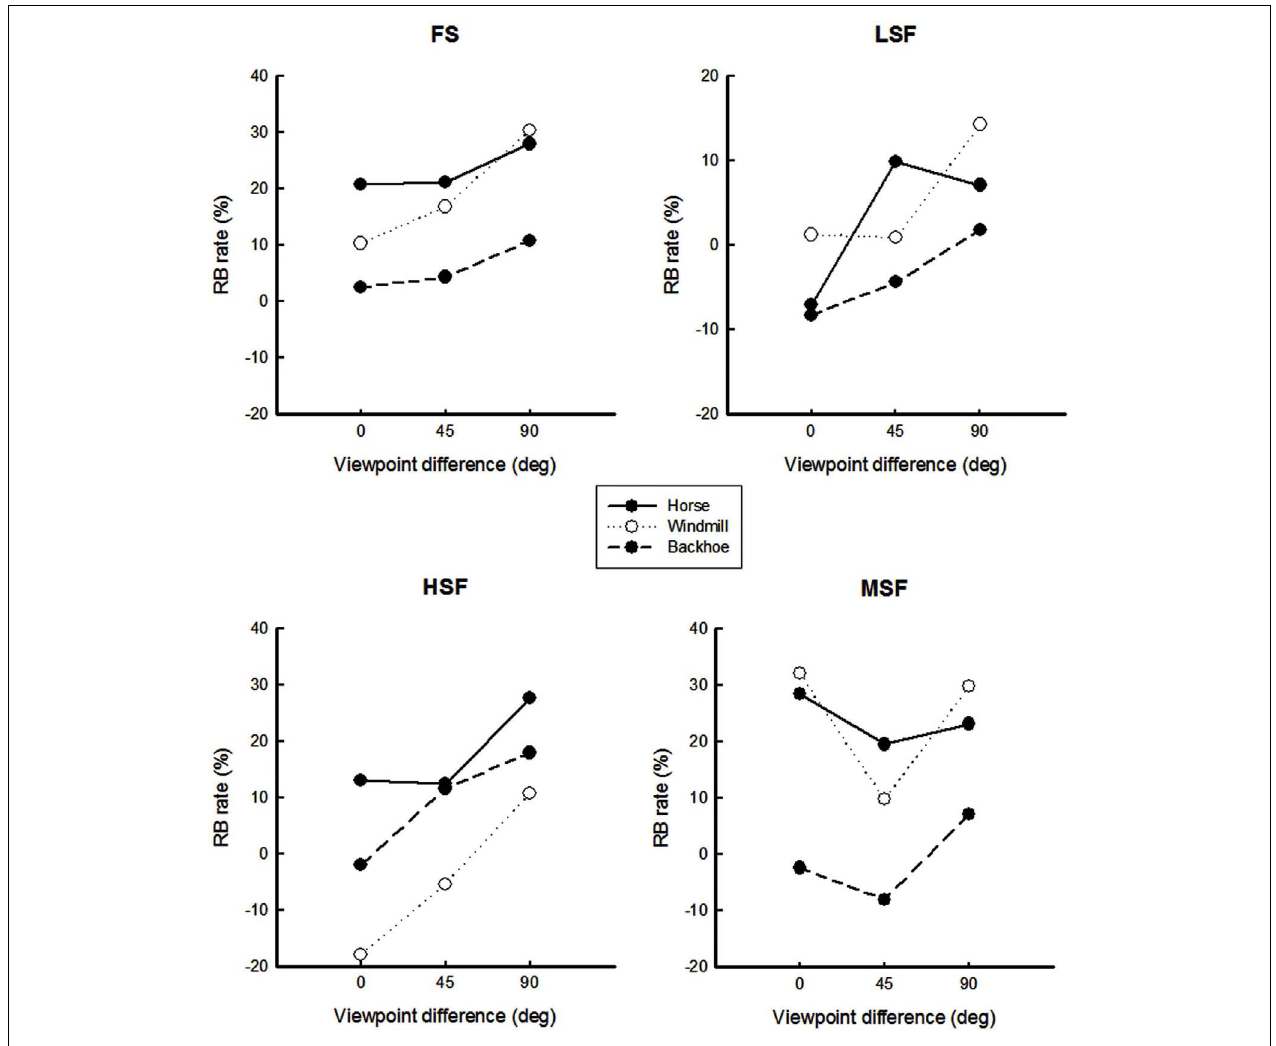
non-repeated condition and the mean correct-response rate in the repeated condition. Error bars are not shown in this figure, to avoid